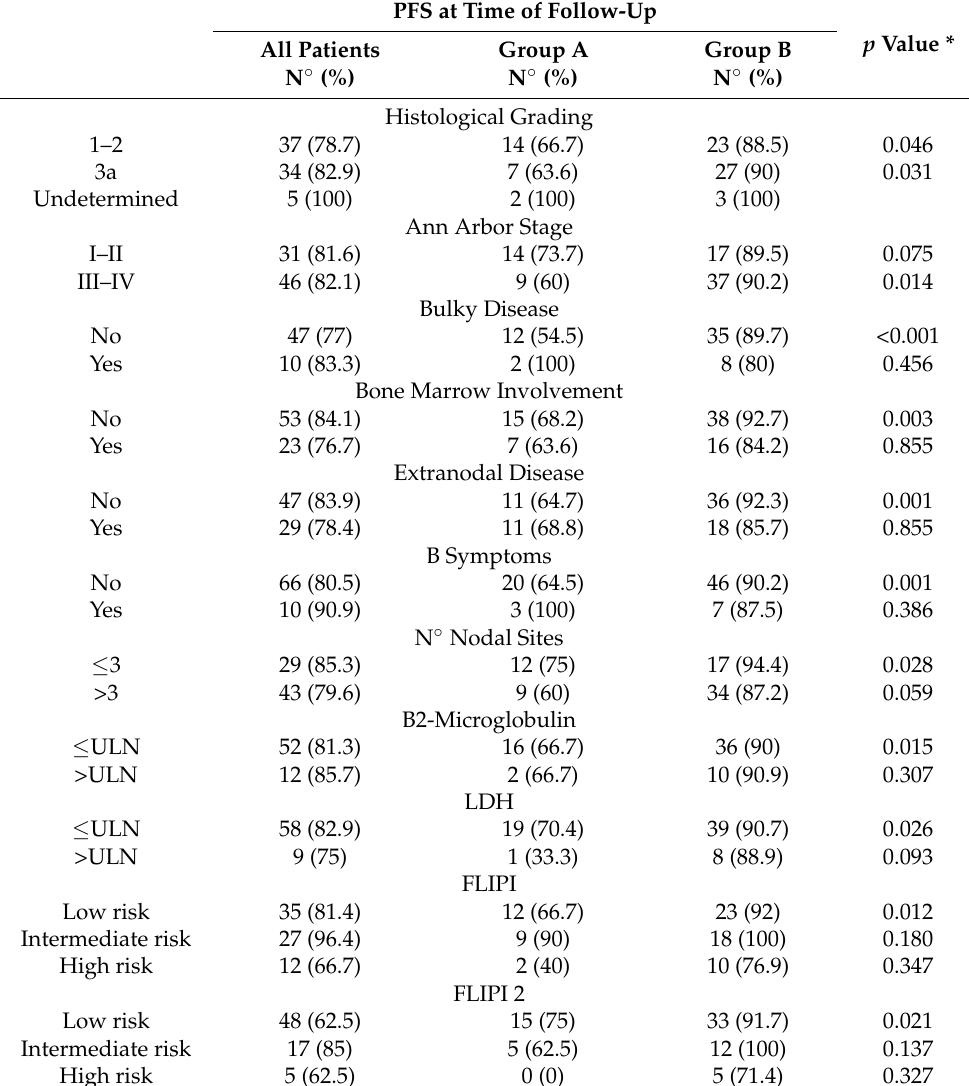
PFS at Time of Follow-Up